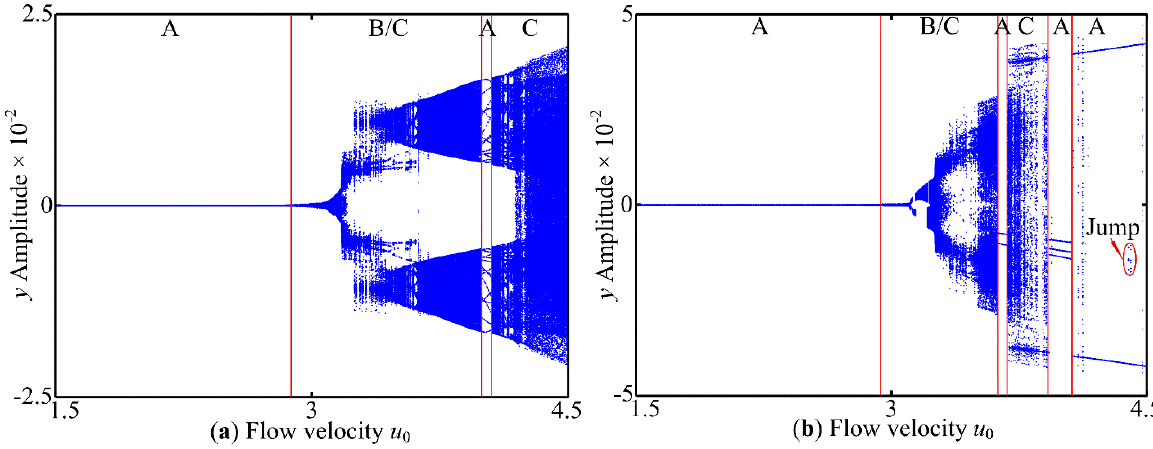
Figure 10. Bifurcation diagram of system response with u 0 : ( a ) k a = 2.6 × 10 6 , k b = 0; ( b ) k a = k b = 0 (A: periodic motion; B: quasi-periodic motion; C: chaotic motion).